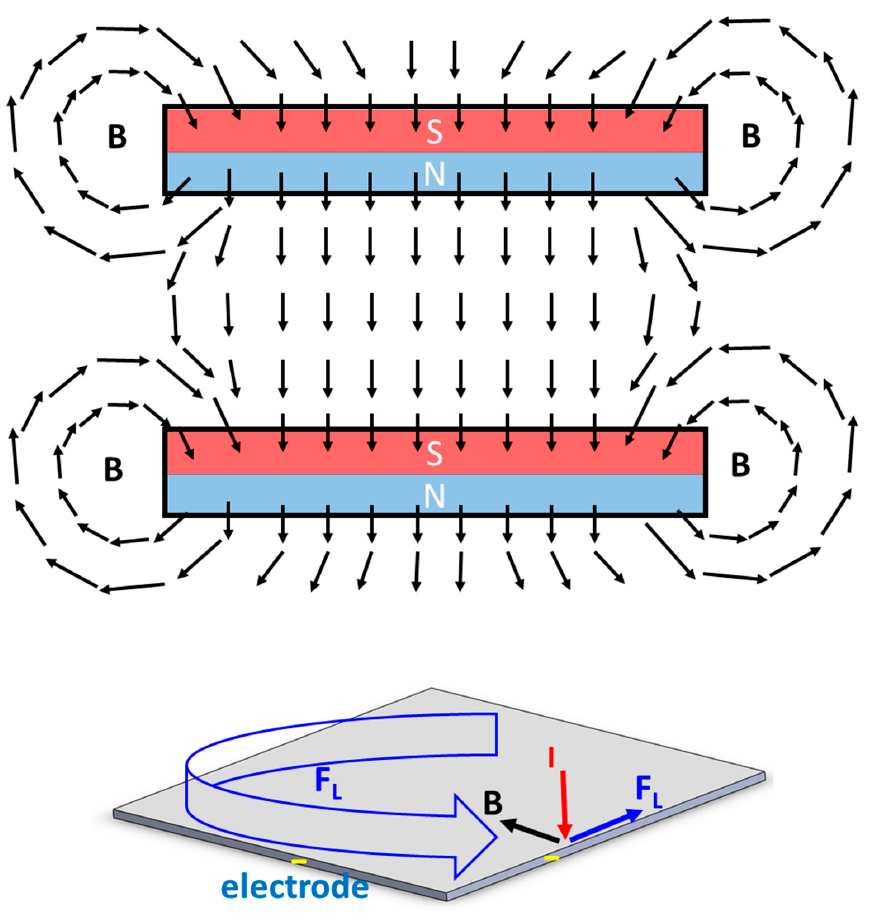
Figure 4. Schematic diagram of the magnetic field vector between two parallel magnets and the direction of Lorentz force near the edge of the electrode when a perpendicular electrical field is applied.